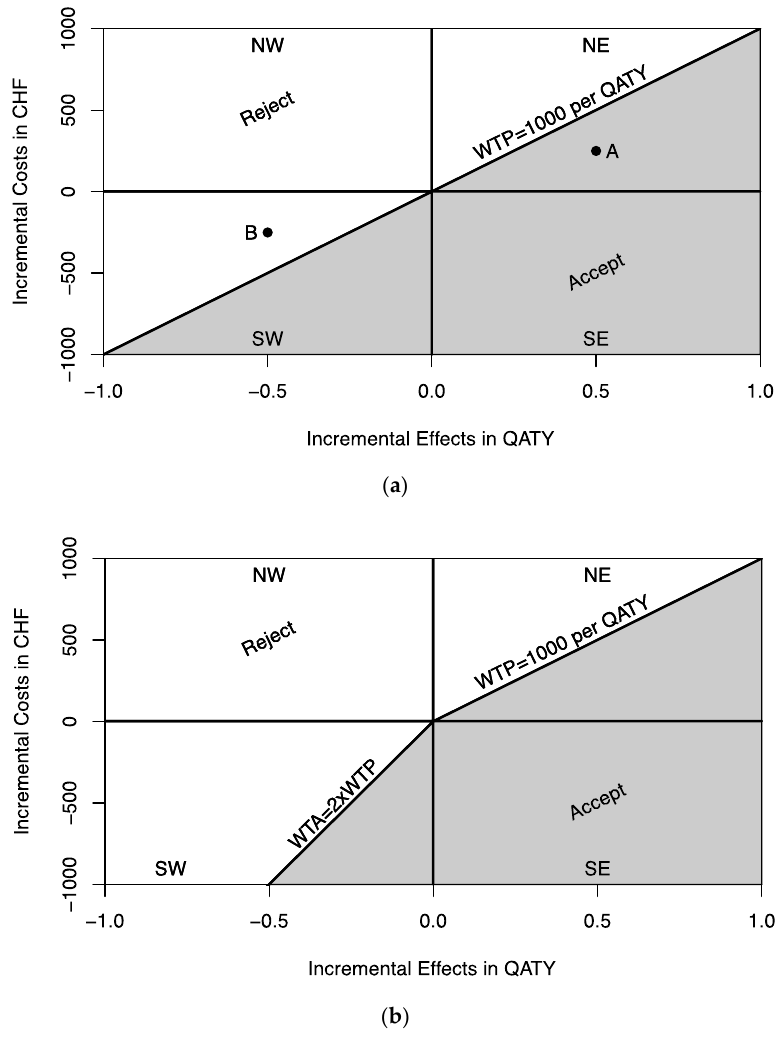
Figure 2. ( a ) Cost-effectiveness plane (WTP = WTA). ( b ) Cost-effectiveness plane (WTP = 2 × WTA). WTA, willingness to accept; WTP, willingness to pay; ceiling ratio WTP = WTA = 1000 $/QATY in ( a ); NW, North-West; SW, South-West; NE, North-East; SE, South-East. In ( a ) Programs A and B have the same ICER of 500 $/QATY; grey shaded area indicates programs with an acceptable ICER in ( a ) and ( b